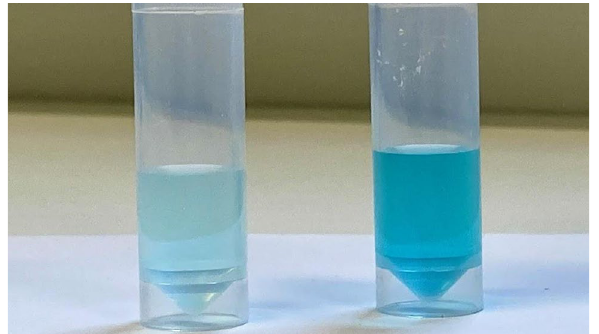
Figure 2. Illustration of quencher binding properties of biopanned phages. Right tube shows a mixture of quencher (brilliant green) and phages (not specific for brilliant green) in a physiological saline solution. The left tube shows the same concentrations of quencher and three cycle biopanned phages against the quencher molecule.